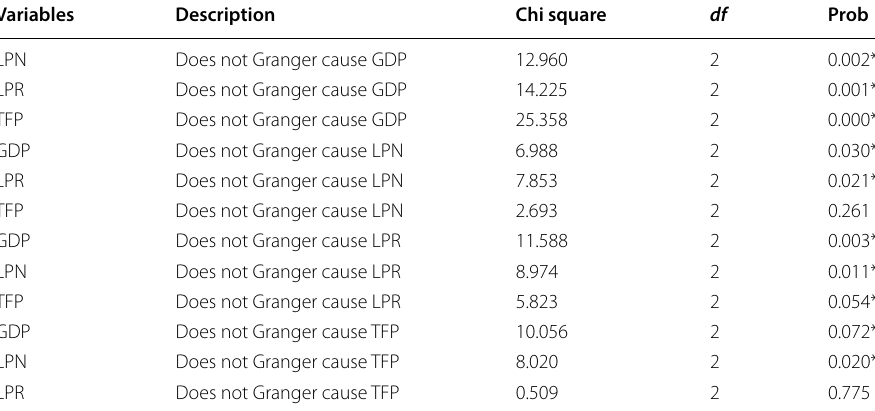
Where *** and *** symbolize 1%, 5% and 10% level of